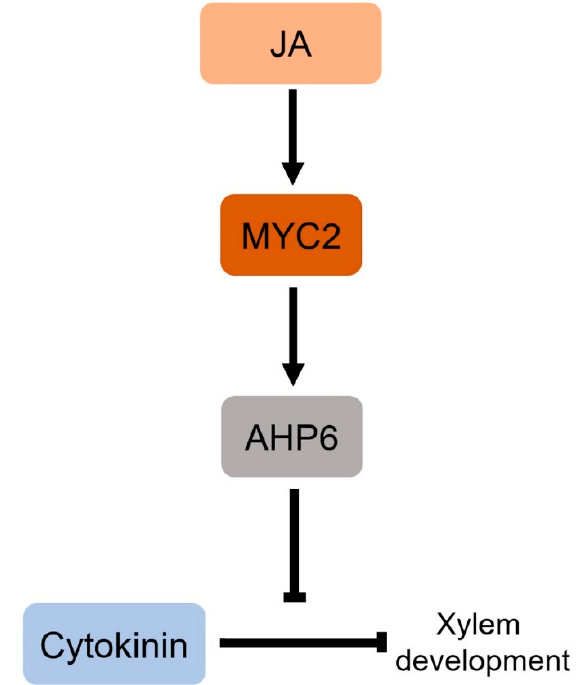
Figure 2. A schematic of crosstalk between JA and cytokinin in xylem development. JA antagonistically interacts with cytokinin in xylem development and the JA-responsive MYC2 transcription factor mediates this process. MYC2 negatively regulates cytokinin response by promoting expression of AHP6 , a cytokinin signaling inhibitor. The arrows and T bars indicate positive and negative regulation, respectively.